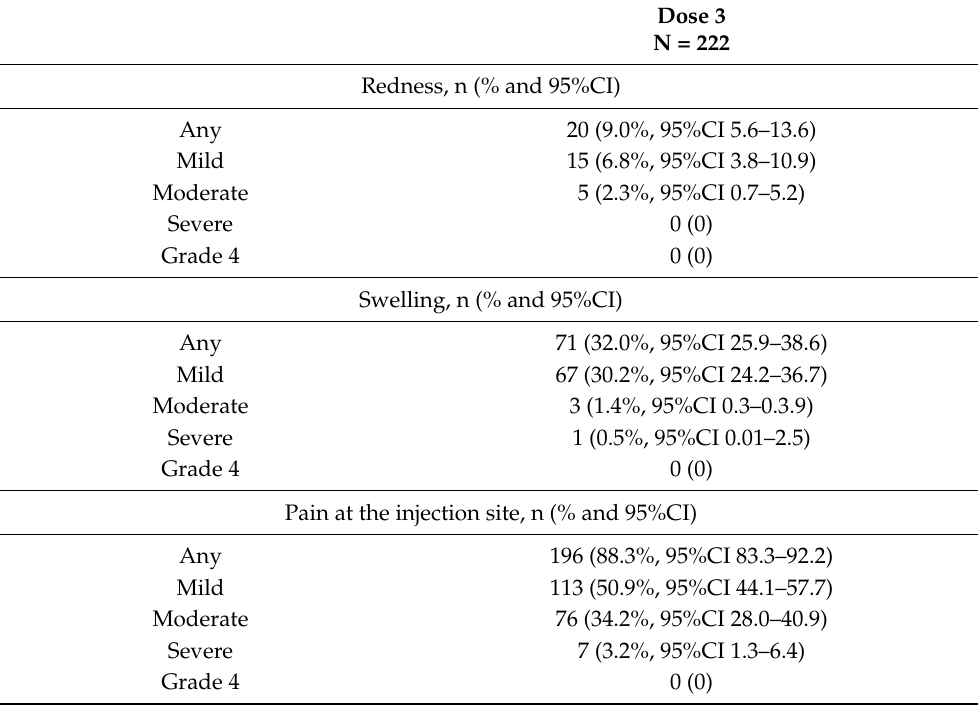
Table 1. Local adverse reactions in the 7 days after the third vaccine dose administration, stratified by symptom severity. “Any” represents the overall reporting of the specific adverse